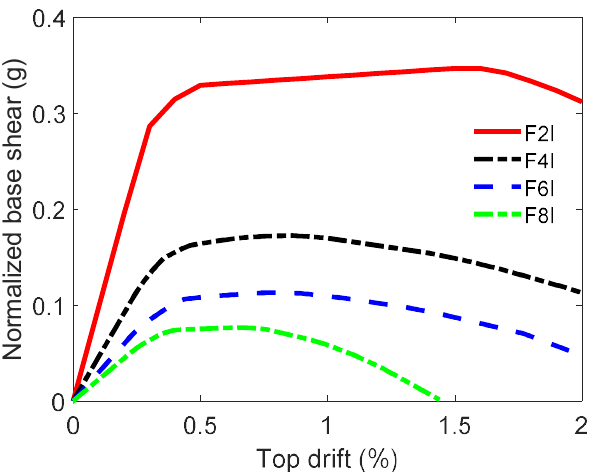
Figure 13. Capacity curves of the different control case structures obtained from pushover analyses.